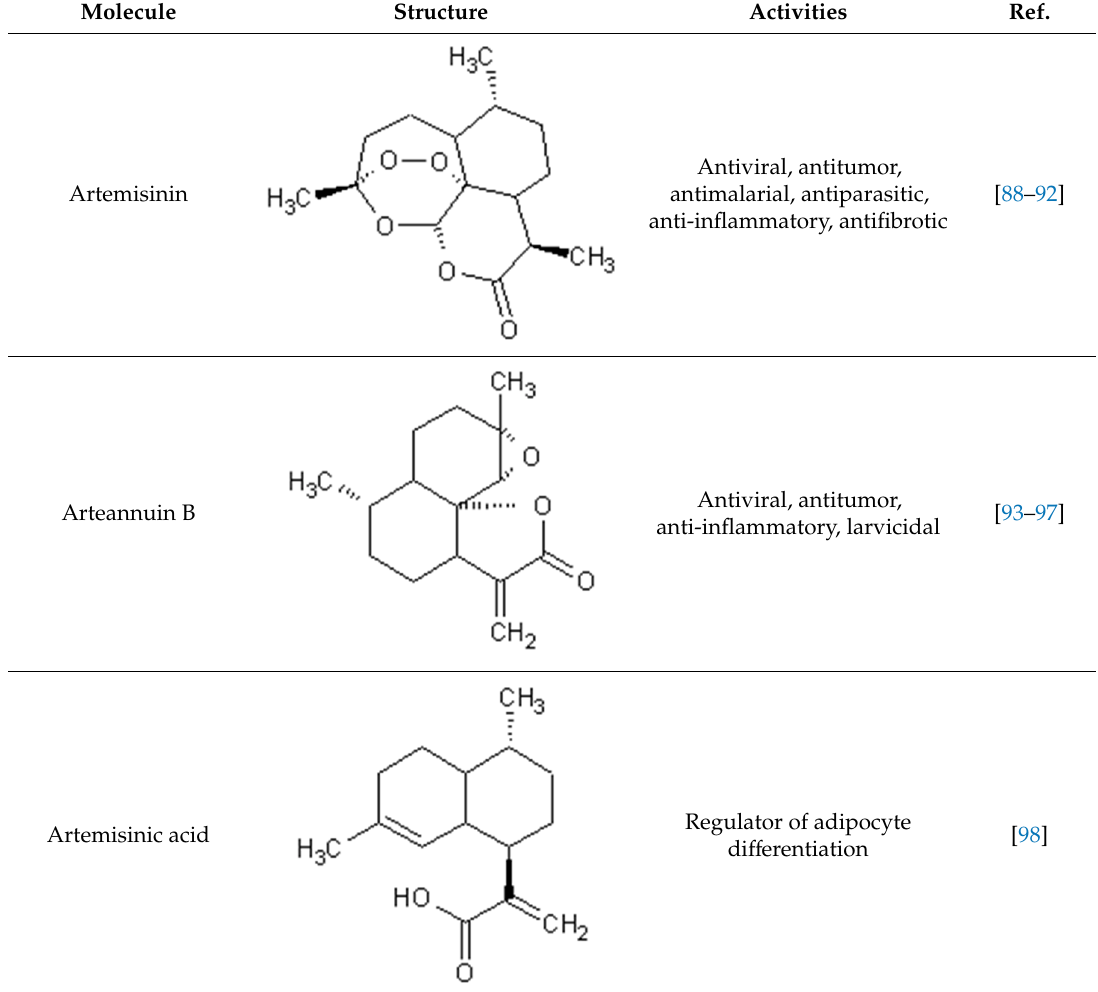
Table 2. Structure and biological activities of major sesquiterpenes of Artemisia annua .